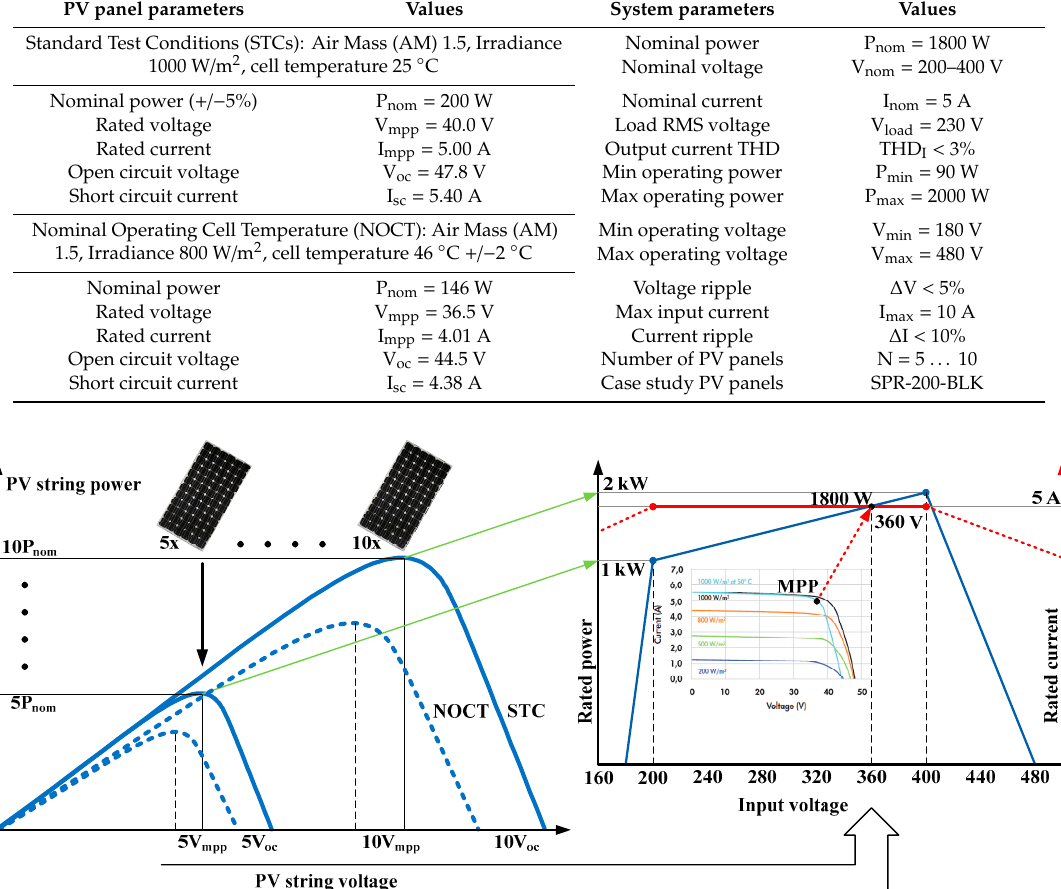
Figure 1. PV string characteristics and system power profile.